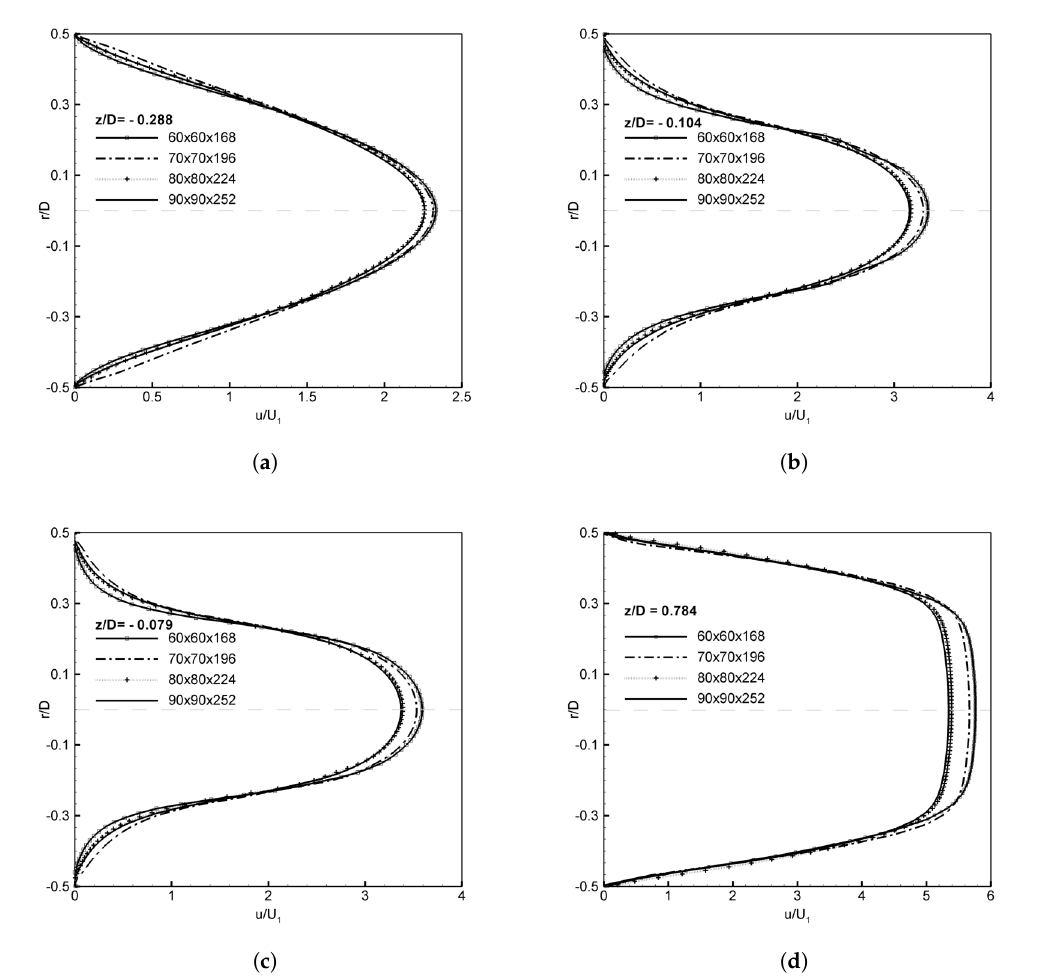
Figure A1. Grid independency at Re D = 365 ( a ) z / D = − 0.288, ( b ) z / D = − 0.104, ( c ) z / D = − 0.079 and ( d ) z / D = +